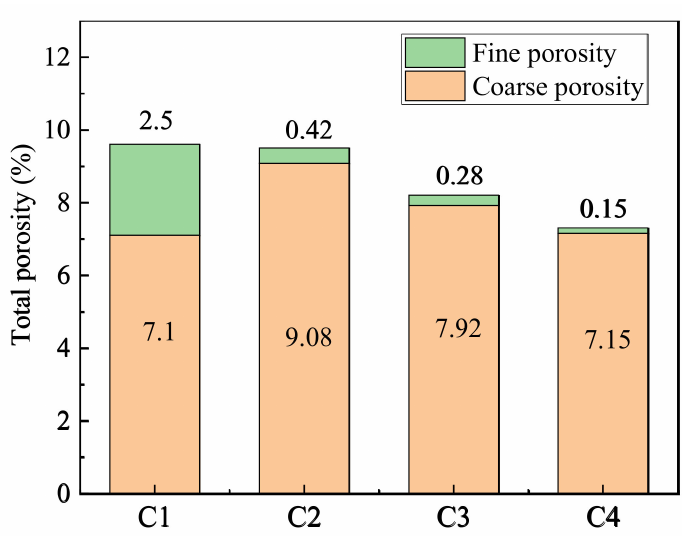
Figure 14. Porosity of recycled concrete at different MSWI content.